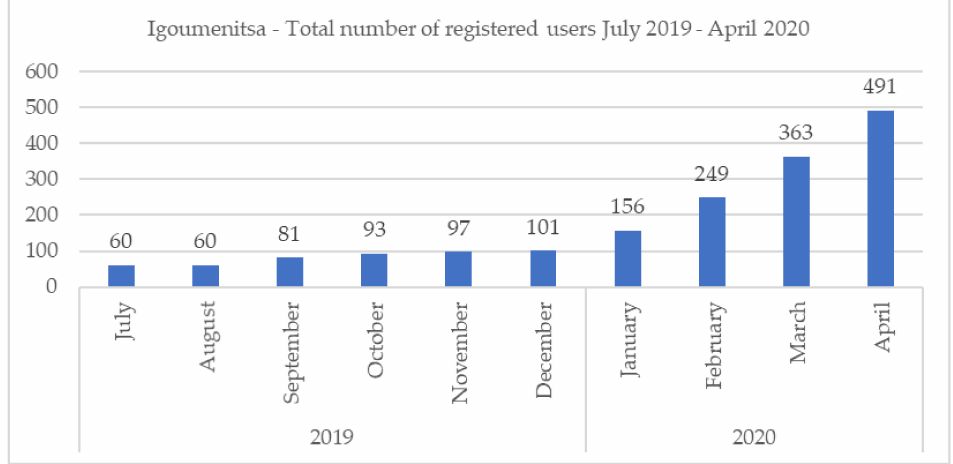
Figure 3. Evolution of the total number of the bike-sharing system’s registered users in the city